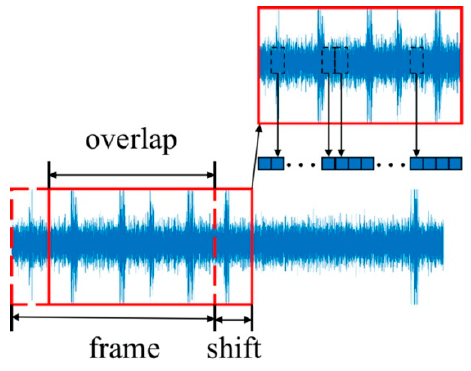
Figure 3. Frame of source domain data.